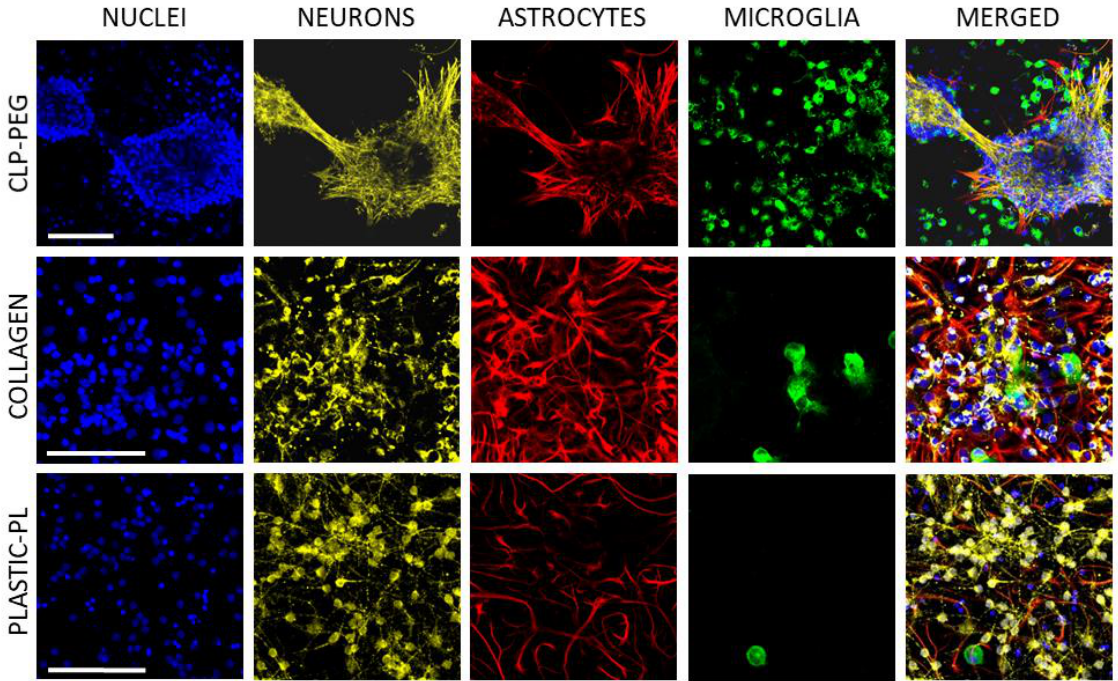
Figure 4. Typical cell culture images of cerebellar cultures after seven days in vitro on CLP-PEG and collagen hydrogels and on poly- L -lysine (PL)-coated glass, respectively. The nuclei were stained blue with Hoechst33342; neurons (yellow) visualized according to microtubule-associated protein 2 (MAP-2), astrocytes (red) according to glial fibrillary acidic protein (GFAP), and microglia visualized green with isolectin GS-IB 4 . The scale bar is 100 µ